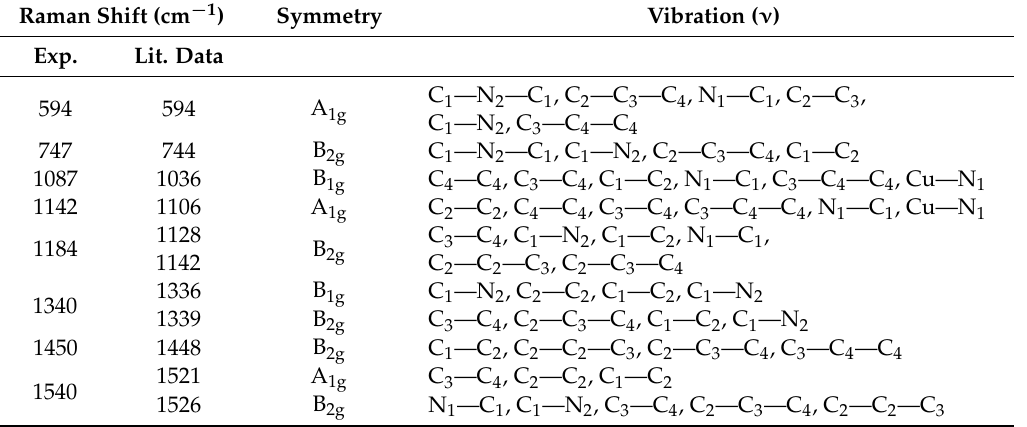
C 2 —C 2 —C 3 , C 2 —C 3 —C